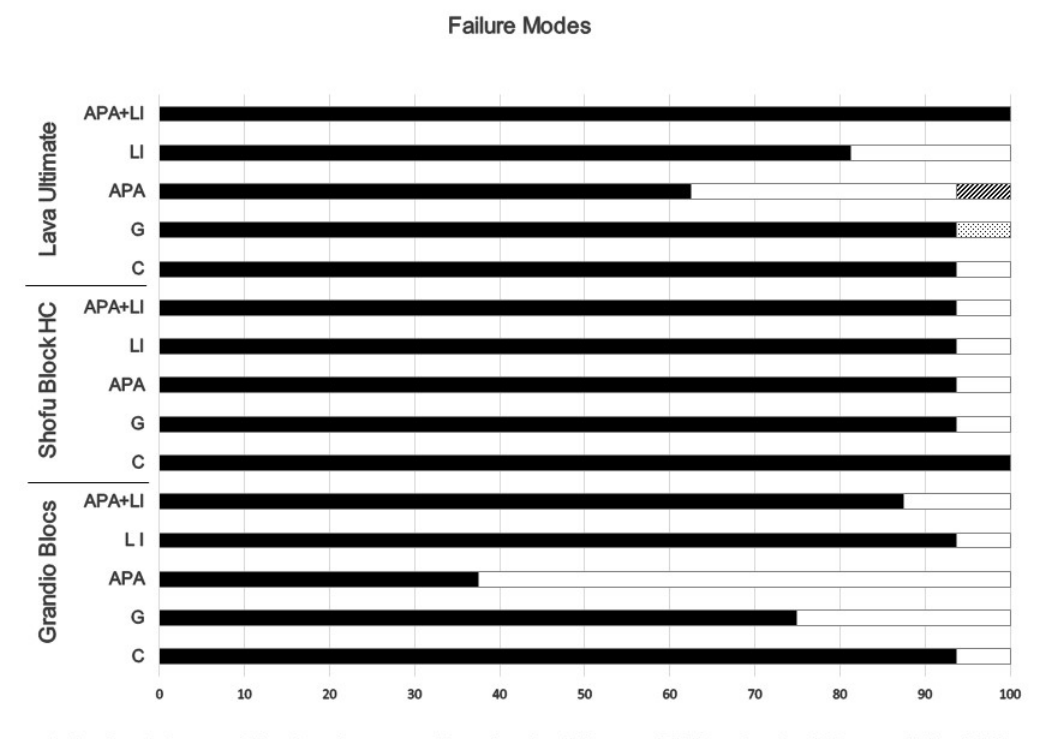
Figure 4. Failure mode distributions (%) of specimens subjected to micro-tensile bond strength test. It was seen that the dominant failure mode was adhesive in all subgroups of RMCs, except for the GB APA group in which direct resin composite cohesive failure was predomi- nantly observed